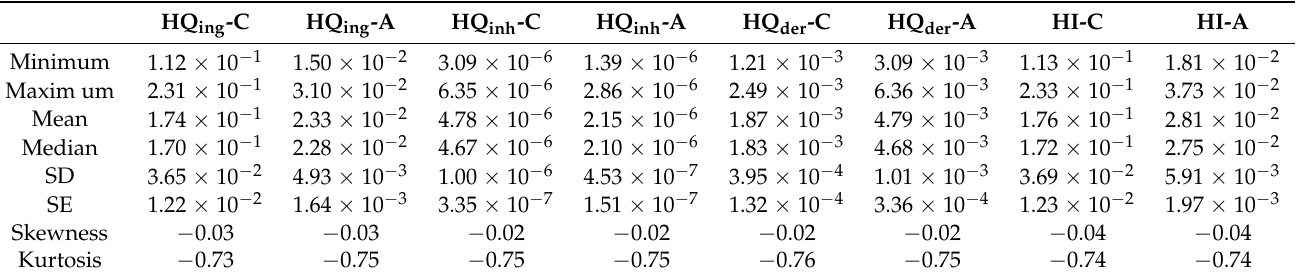
Table 6. Overall values of hazard quotient (HQ), and hazard index (HI), in the three exposure routes of Pb for children (C) and adults (A) in in Klang River estuary and a site in Juru estuary. N= 9. HQ ing -C HQ ing -A HQ inh -C HQ inh -A HQ der -C HQ der -A HI-C HI-A